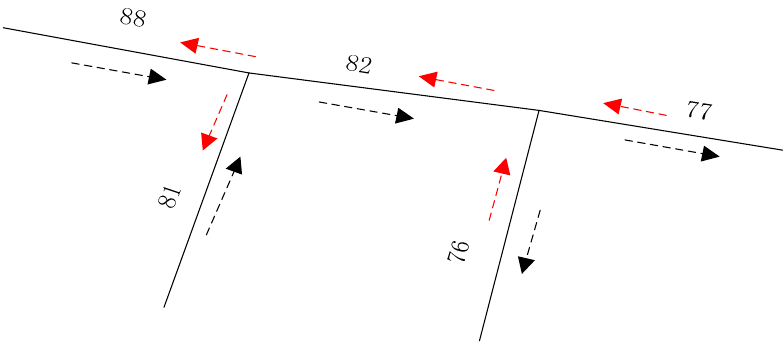
Figure 2. Schematic diagram of traffic flow. Red line represents traffic flow in one direction and black line are opposite.